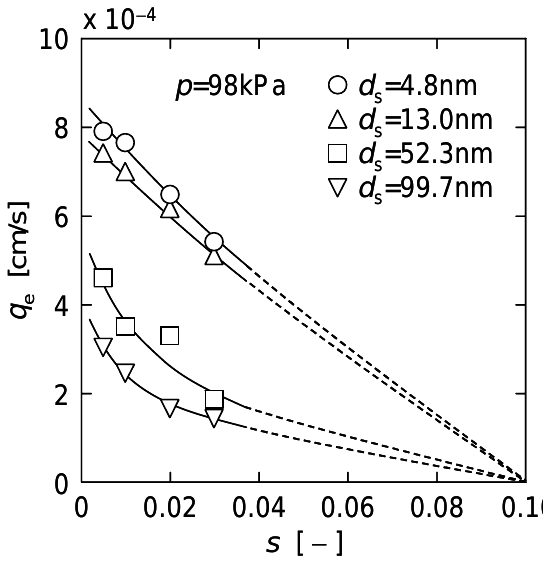
Figure 7. Effect of particle concentration on steady filtration